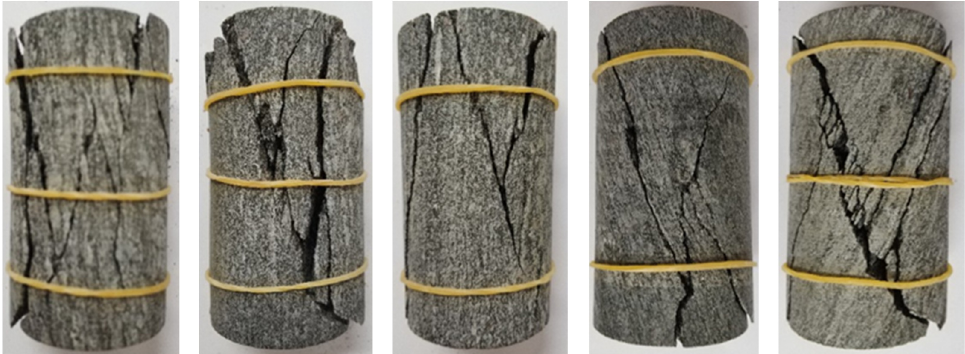
Figure 9. Failure modes of gneiss in the high geostress area. ( a ) 5 MPa. ( b ) 10 MPa. ( c ) 15 MPa. ( d ) 20 MPa. ( e ) 25 MPa.